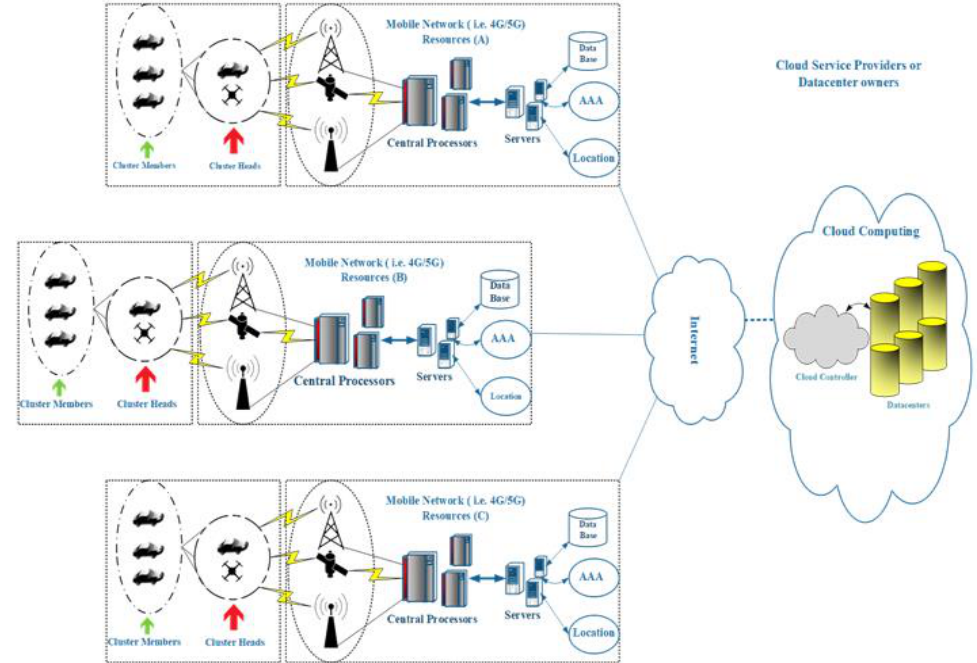
Figure 2. Flying wireless backbone assisted architecture.